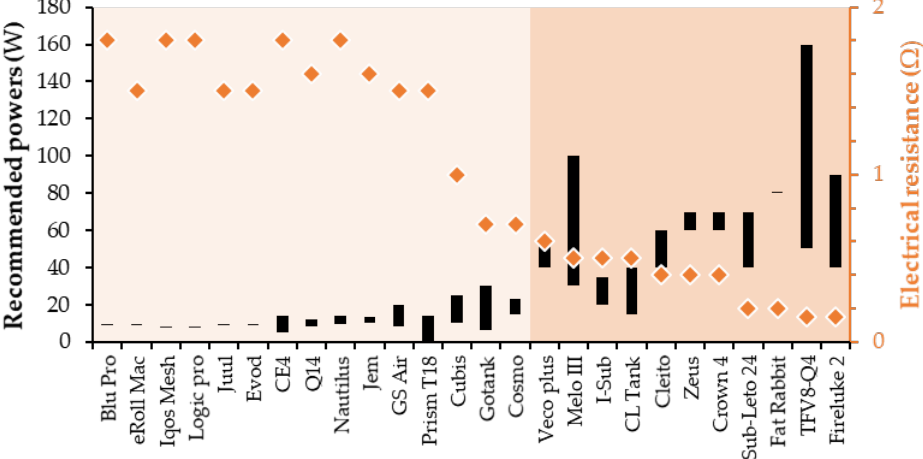
Figure 9. Recommended powers of the twenty-six tested devices regarding their electrical resistance values.